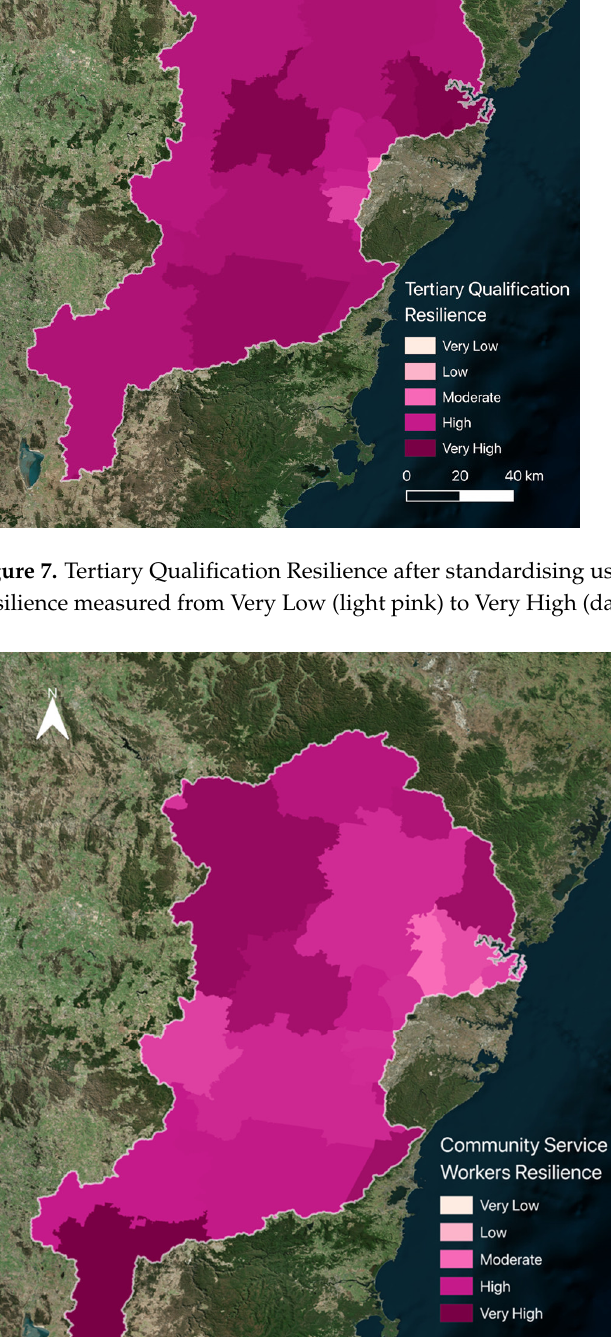
Figure 8. Community Service Workers Resilience after standardising using fuzzy membership processing. Resilience measured from Very Low (light pink) to Very High (dark pink).